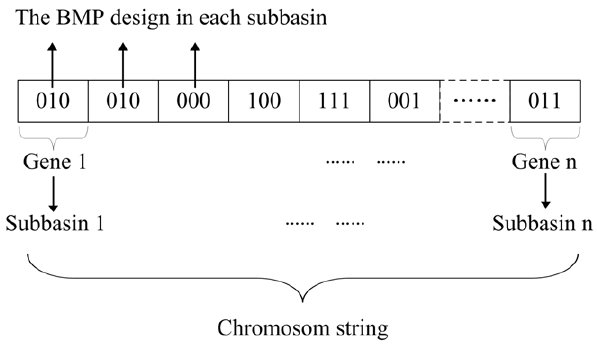
Figure 2. The population of chromosomes associated with the structural